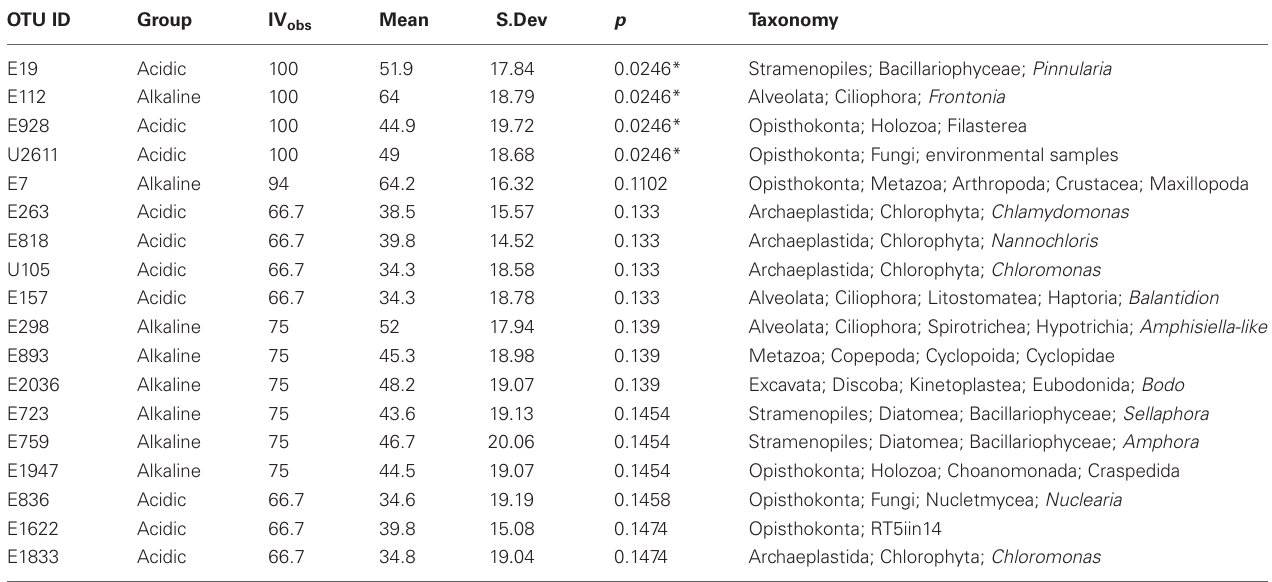
Table A3 | Indicator “OTU” analysis showing indicator values for representative groups.